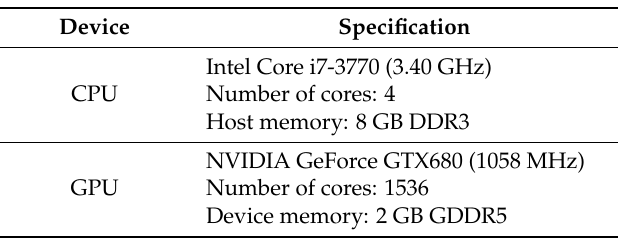
Table 1. Hardware specification in the